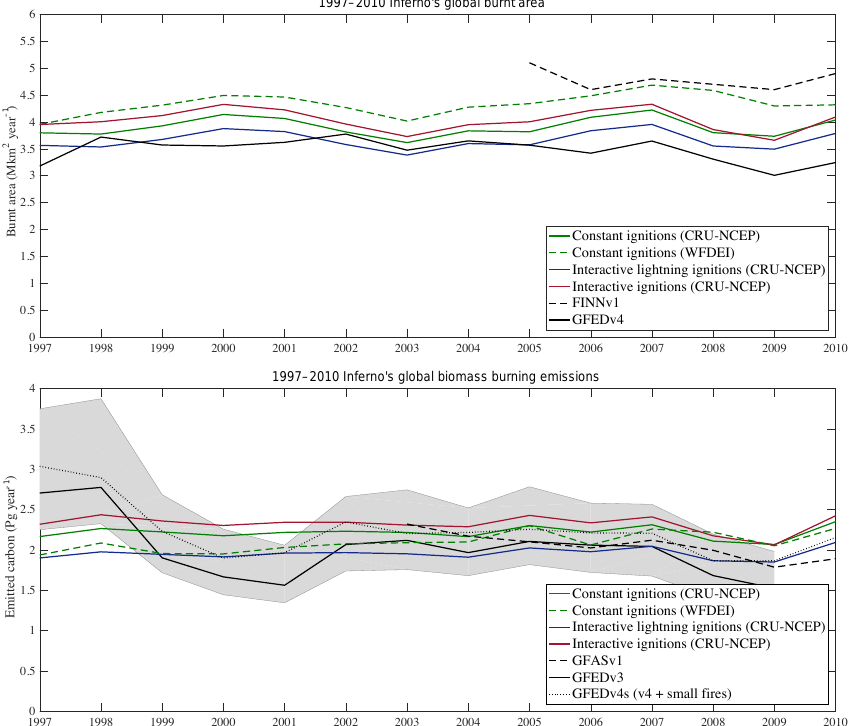
Figure 3. 1997–2010 biomass burning emissions and burnt area predicted by INFERNO. Two driving data sets were used, CRU-NCEP (solid lines) and WFDEI (green dotted line). Observations are shown in black (MODIS-based estimates). The grey shading represents 1 standard deviation within GFEDv3’s